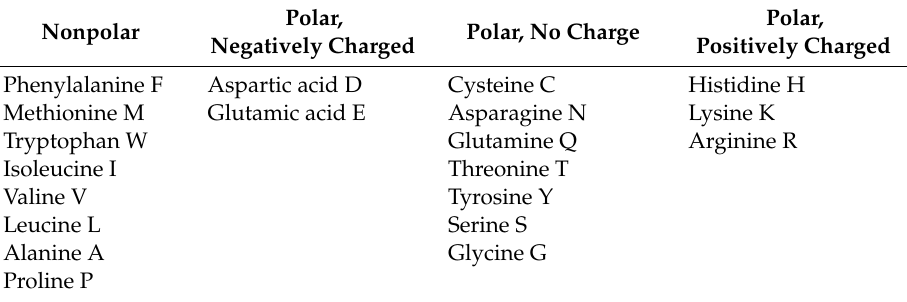
Table 4. Classification of amino acids by polarity and